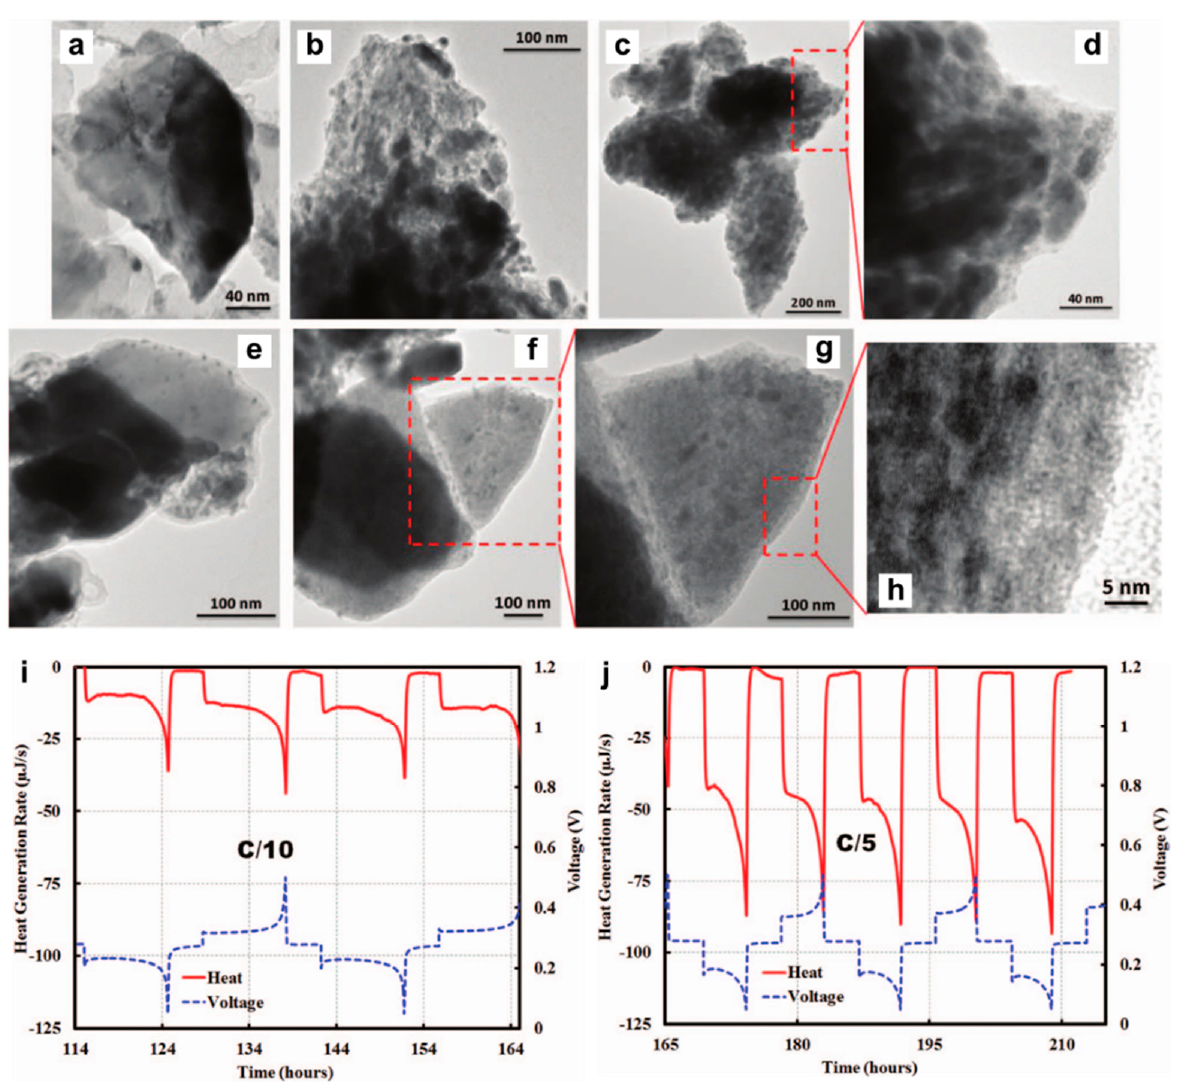
Figure 2. TEM images depicting the structure transformations of Bi during the processes of magnesia- tion/demagnesiation, ( a ) pristine Bi, ( b ) 50% magnesiated Bi, ( c , d ) 100% magnesiated Bi (i.e., Mg 3 Bi 2 ), ( e ) 50% demagnesiated Mg 3 Bi 2 , and ( f – h ) 100% demagnesiated Mg 3 Bi 2 (i.e., Bi). In situ heat gener- ated by the Mg/Bi coin cell during magnesiation/demagnesiation using IMC at ( i ) C/10 and ( j ) C/5 rate, respectively. Reproduced with permission [25]. Copyright 2015, Institute of